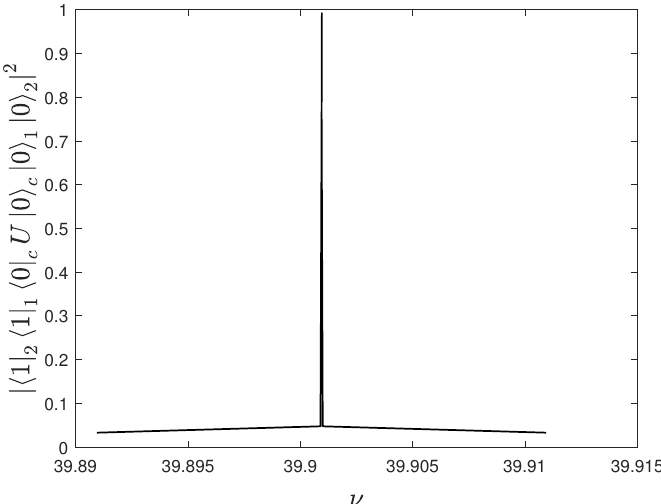
2 as a function of the modulation U ( t ) 0 1 ,0 2 1 1 ,1 2 |(cid:104) | | (cid:105)| ω 1 + ω 2 , ω 1 = 10, ω 2 = 3 ω 1 , ≈